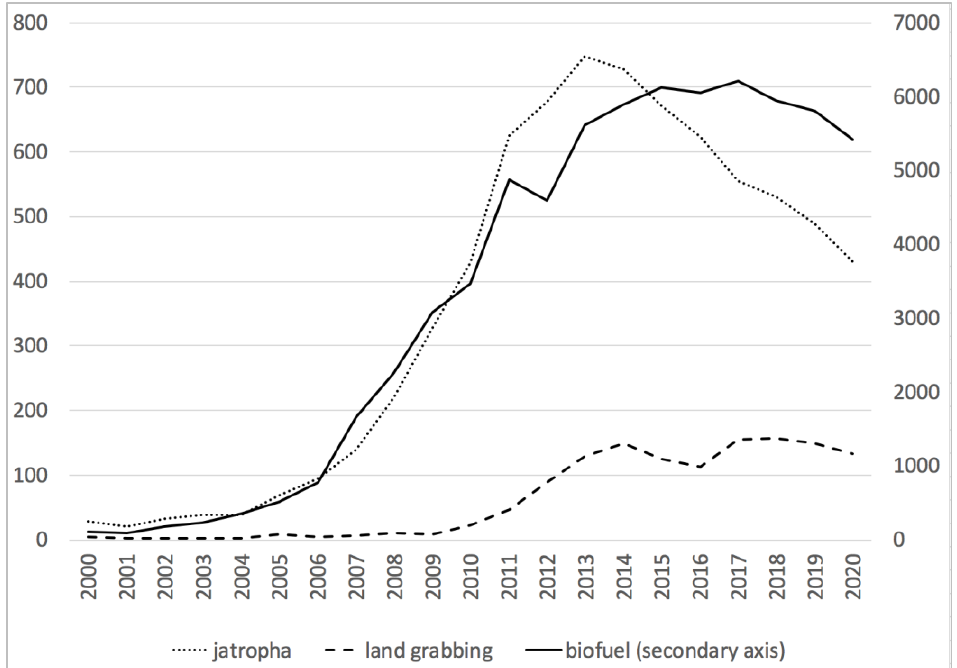
Figure 1. Number of academic articles published on iatropha, land grabbing and biofuels between 2000 and 2020, source: author, data from a Web of Science search carried out on 25 February 2021.